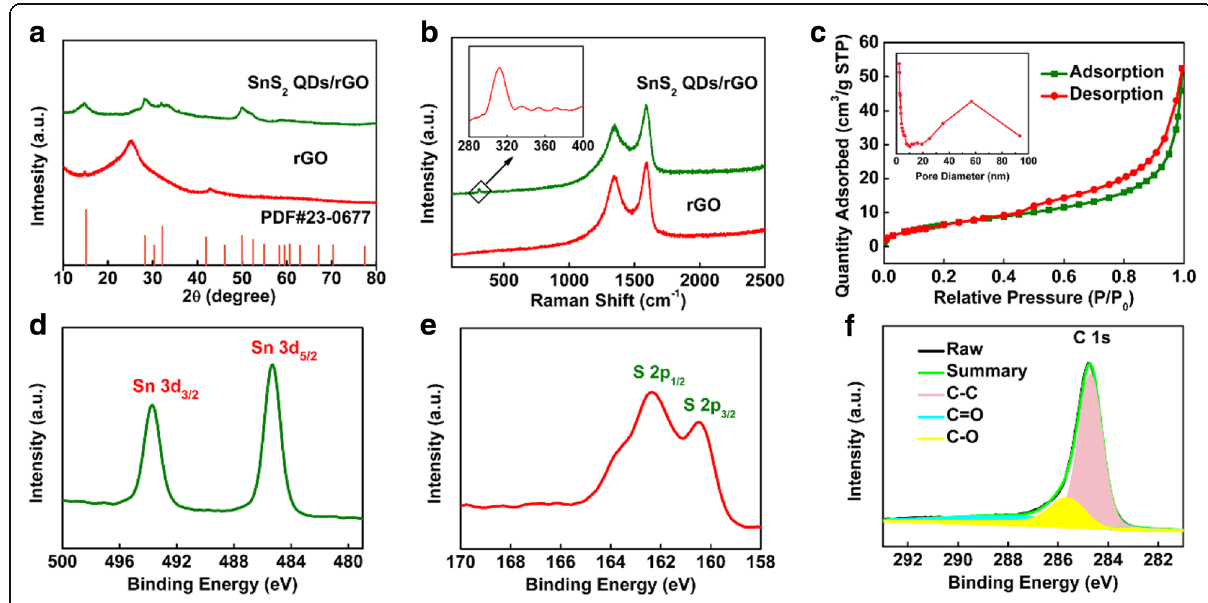
Fig. 2 a XRD pattern and b Raman spectra of the rGO and 3D SnS 2 QDs/rGO composite. c N 2 adsorption – desorption isotherms and the corresponding pore size distributions of the 3D